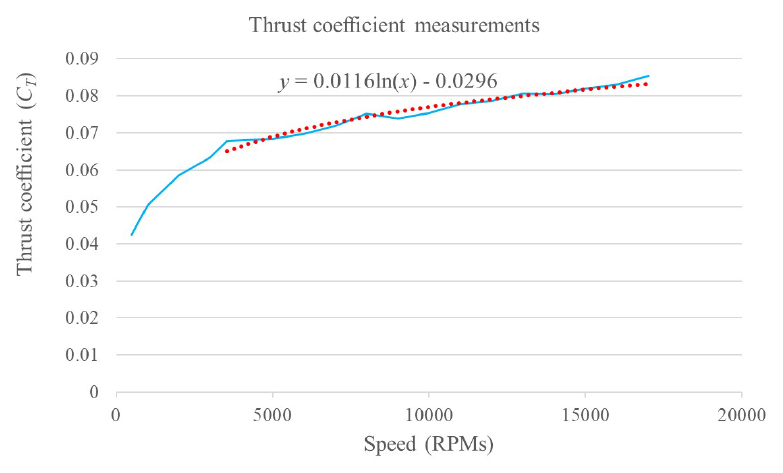
Figure 6. Thrust coefficient graph based on EMAX MT2204 2300KV motor thrust force